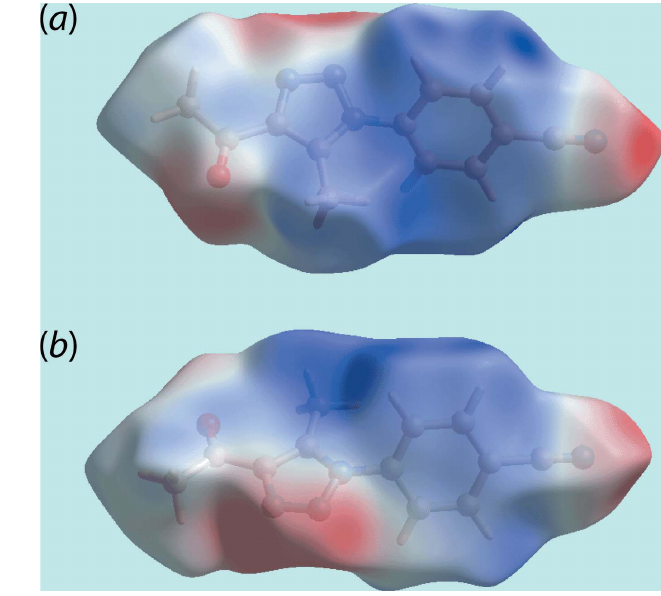
Figure 4 Two views of the Hirshfeld surface mapped over the electrostatic potential in the range (cid:4) 0.092 to +0.055 a.u. The red and blue regions represent negative and positive electrostatic potentials, respectively.